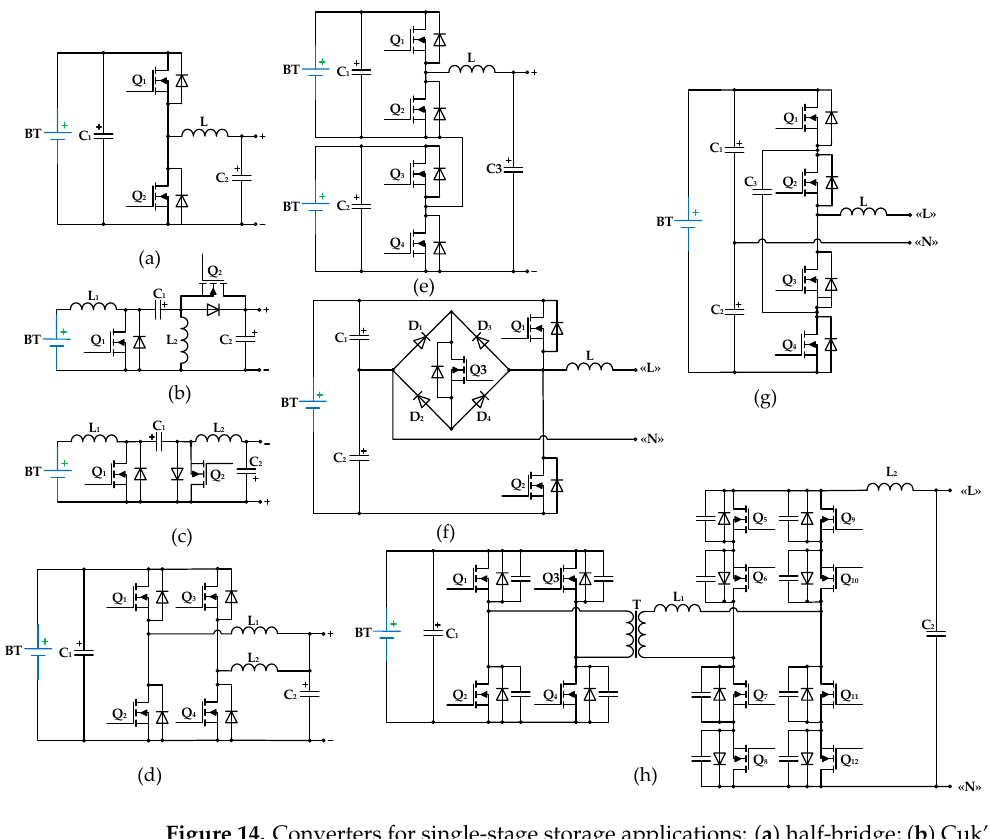
Figure 14. Converters for single-stage storage applications: ( a ) half-bridge; ( b ) Cuk’; ( c ) SEPIC/Luo; ( d ) interleaved half-bridge; ( e ) cascaded half-bridge; ( f ) half-bridge rectifier with neutral point switch clamped scheme; ( g ) capacitor clamped three-level; ( h ) high-frequency-link inverter.